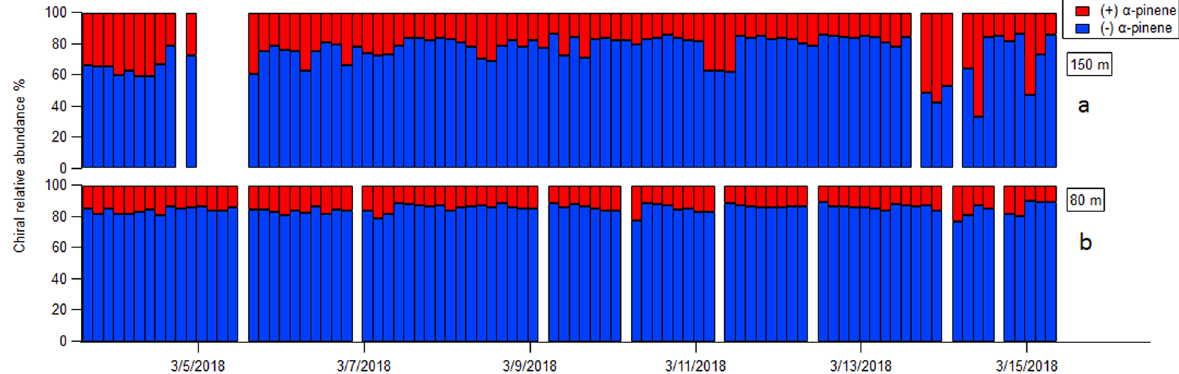
Fig. 5 Relative percentage of ( − )- α -pinene and ( + )- α -pinene air mixing ratios measured at 80 and 150 m up the ATTO tower during the wet season in 2018. Each bar corresponds to a sample collected from the tower. Diel pro fi le of the chiral ratios measured at each height with the standard deviation of the dataset are shown in Supplementary Fig.